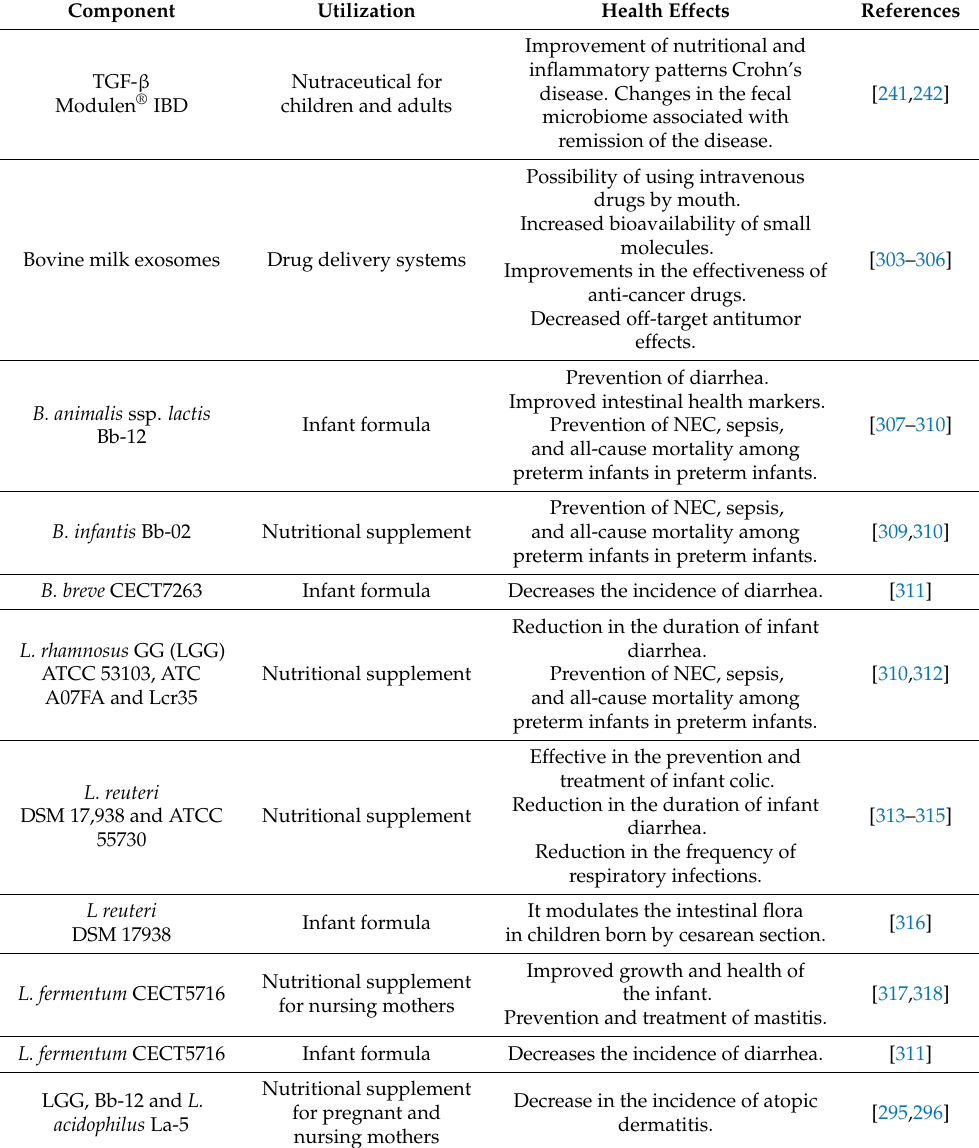
Table 4. Examining other breast milk components used in health applications, summary of evidences (clinical trials, cohort studies, and